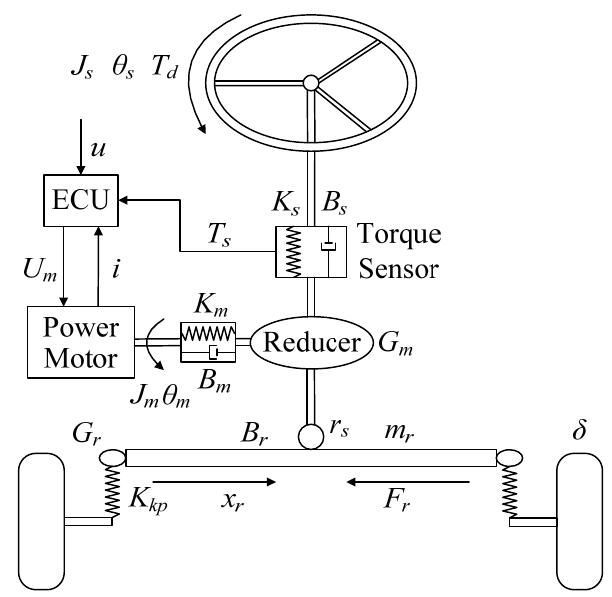
Figure 2. Electric power steering system